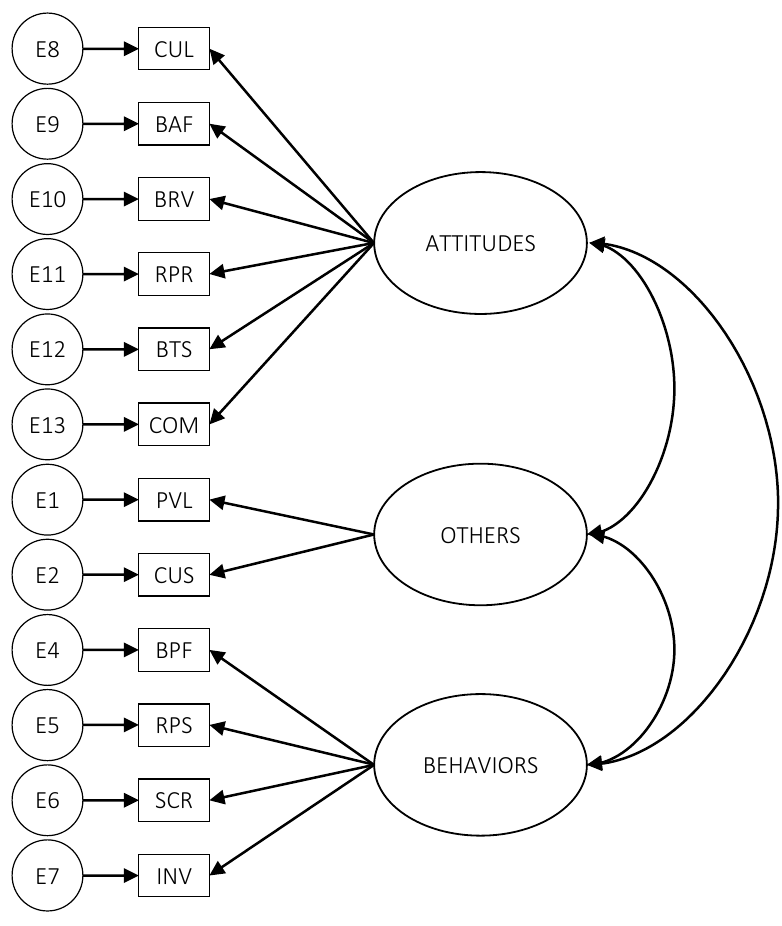
Figure 1. A theoretical model to measure and manage brand loyalty of banks’